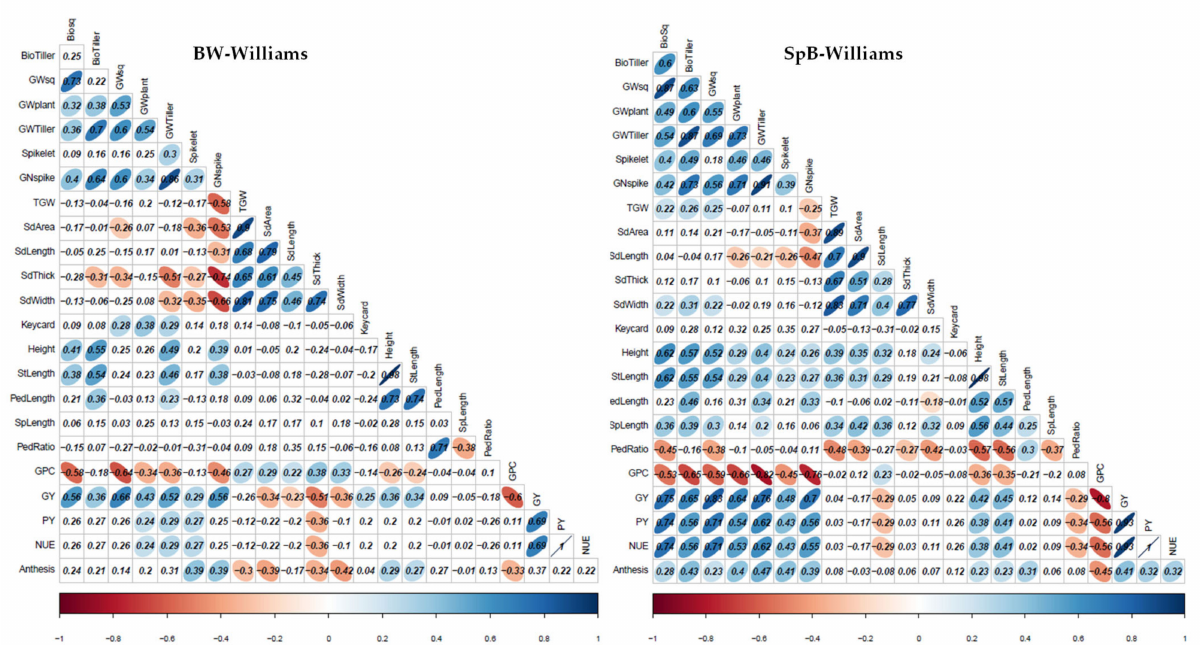
Figure 3. Phenotypic correlations between yield-related traits in Williams in BW and SpB populations. The values are correlation coefficients r. The areas and colors of ellipses show the absolute values of the corresponding correlations. Right and left oblique ellipses indicate positive and negative correlations, respectively. The values without ellipses indicate insignificance at the 0.05 level. Biosq: plant biomass per m 2 ; BioTiller: biomass per tiller; GWsq: grain weight per m 2 ; GWplant: grain weight per plant; GWTiller: grain weight per tiller; Spikelet: spikelet number per spike; GNspike: grain number per spike; TGW: thousand grain weight; SdArea: seed area; SdLength: seed length; SdThick: seed thickness; SdWidth: seed width; Keycard: keycard diameter; Height: plant height; StLength: stem length; PedLength: peduncle length; SpLength: spike length; PedRatio: peduncle ratio; GPC: grain protein content; GY: grain yield; PY: protein yield; NUE: nitrogen use efficiency; Anthesis: days to